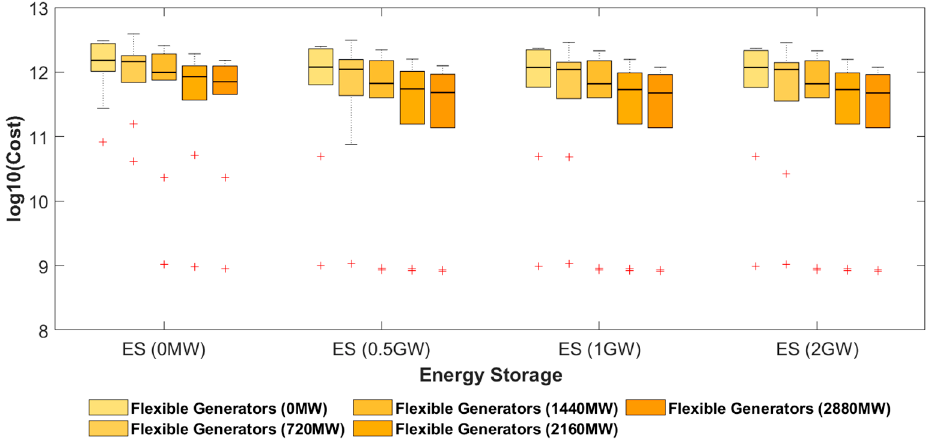
Figure 7. Cost comparison of multi-scenario unit scheduling in spring.